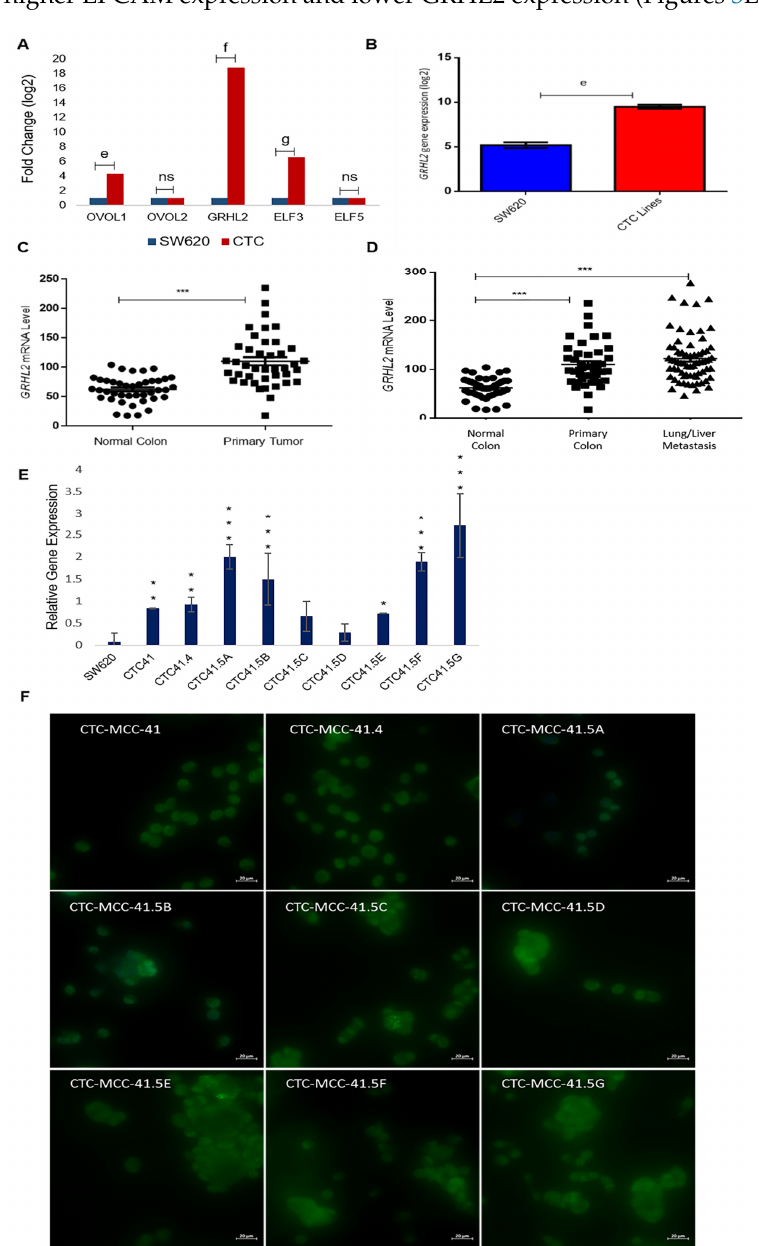
Figure 3. Upregulation of the mesenchymal-to-epithelial transition (MET) marker GRHL2 in the nine colorectal CTC lines and in colorectal cancer samples. ( A ) Comparison of the expression of the indicated MET transcription factors in CTC lines and SW620 cells (microarray data). ( B ) The GRHL2 MET marker is significantly upregulated in CTC lines compared with SW620 cells. ( C ) GRHL2 mRNA level in paired normal colorectal epithelium and primary colorectal cancer samples ( n = 27). Data are from a cohort of patients with colon neoplasms (GSE41258). ( D ) GRHL2 mRNA level (same cohort as in ( C )) in normal colorectal epithelium ( n = 41), primary ( n = 41), and lung and liver metastatic ( n = 66) colorectal cancer samples. ( E ) GRHL2 relative gene expression by RT-qPCR in SW620 cells and in each CTC line. ( F ) Immunofluorescence analysis of GRHL2 protein expression in the nine CTC cell lines. e: p -value = 2.71 × 10 − 9 ; f: p -value = 1.80 × 10 − 17 ; g: p -value = 1.54 × 10 − 12 . All the RT-qPCR results were normalized to the B2M expression level in each sample; * p < 0.05, ** p < 0.01, *** p < 0.001, ns: not